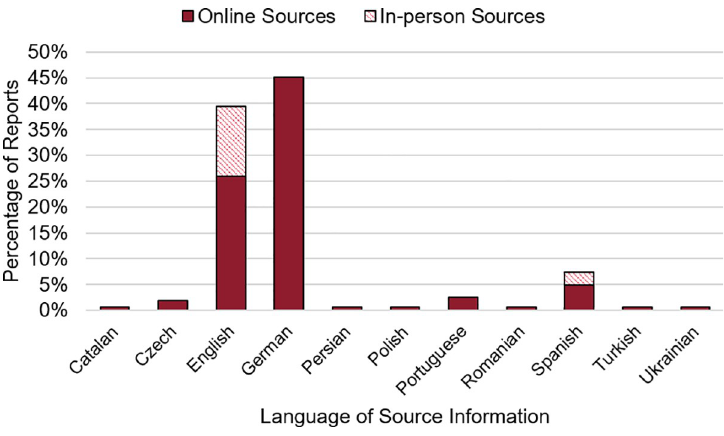
Fig 8. Landslide event sources by language and type of source. The event source specified in the “source name” and “source link” fields for each citizen scientist-contributed report are categorized by language and by the type of source, an in-person observation or an online